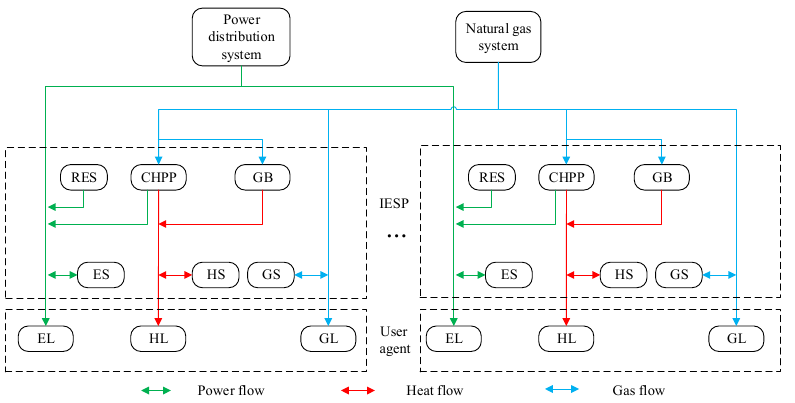
Figure 1. Physical structure for IESP interactive operation.